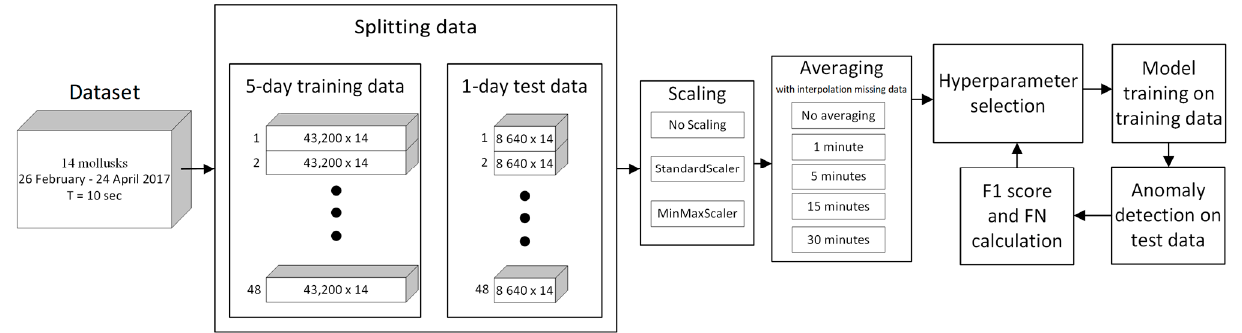
Figure 3. Blocks diagram of the algorithm.